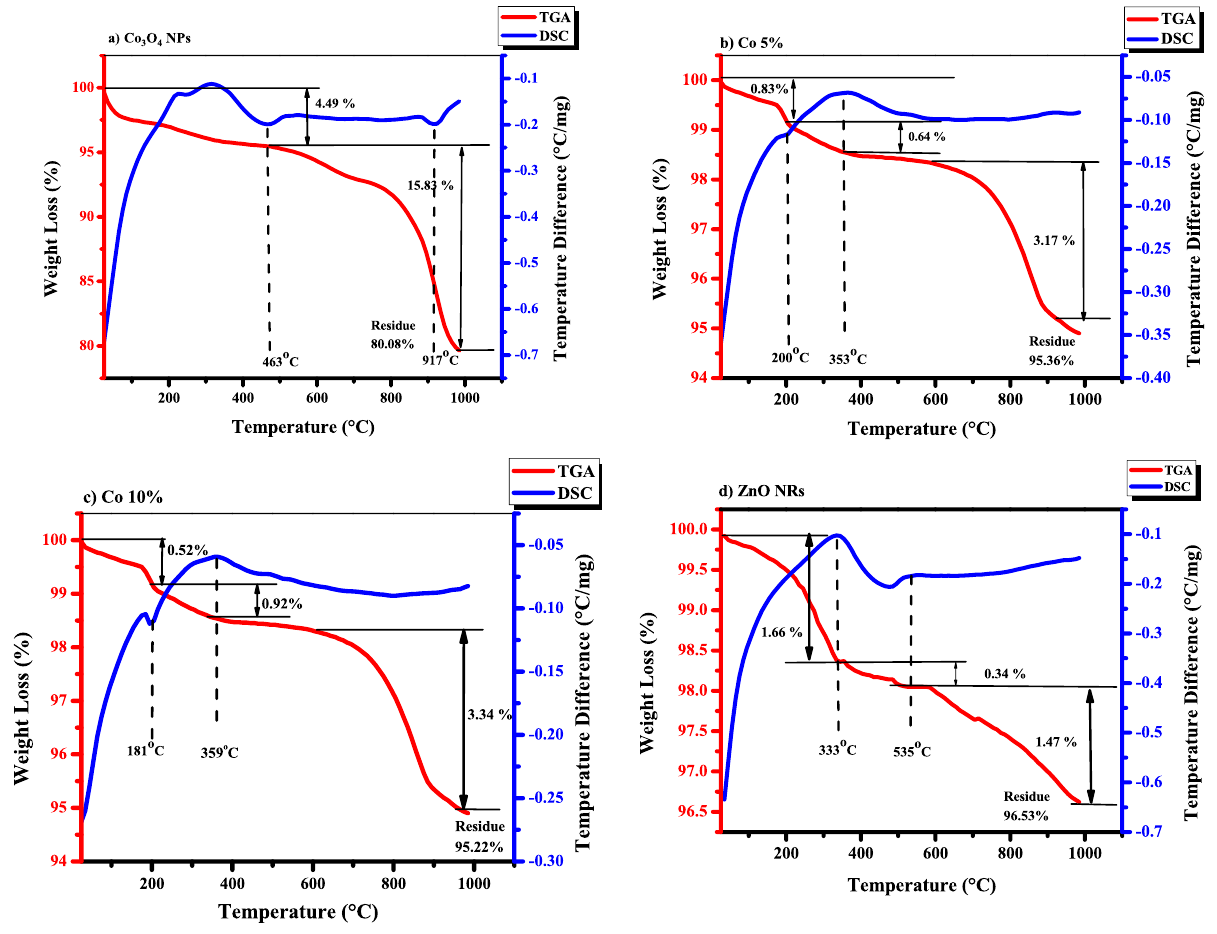
Figure 12. TGA and DSC analysis of ( a ) Co 3 O 4 NPs, ( b ) Co 5%, ( c ) Co 10% and ( d ) ZnO